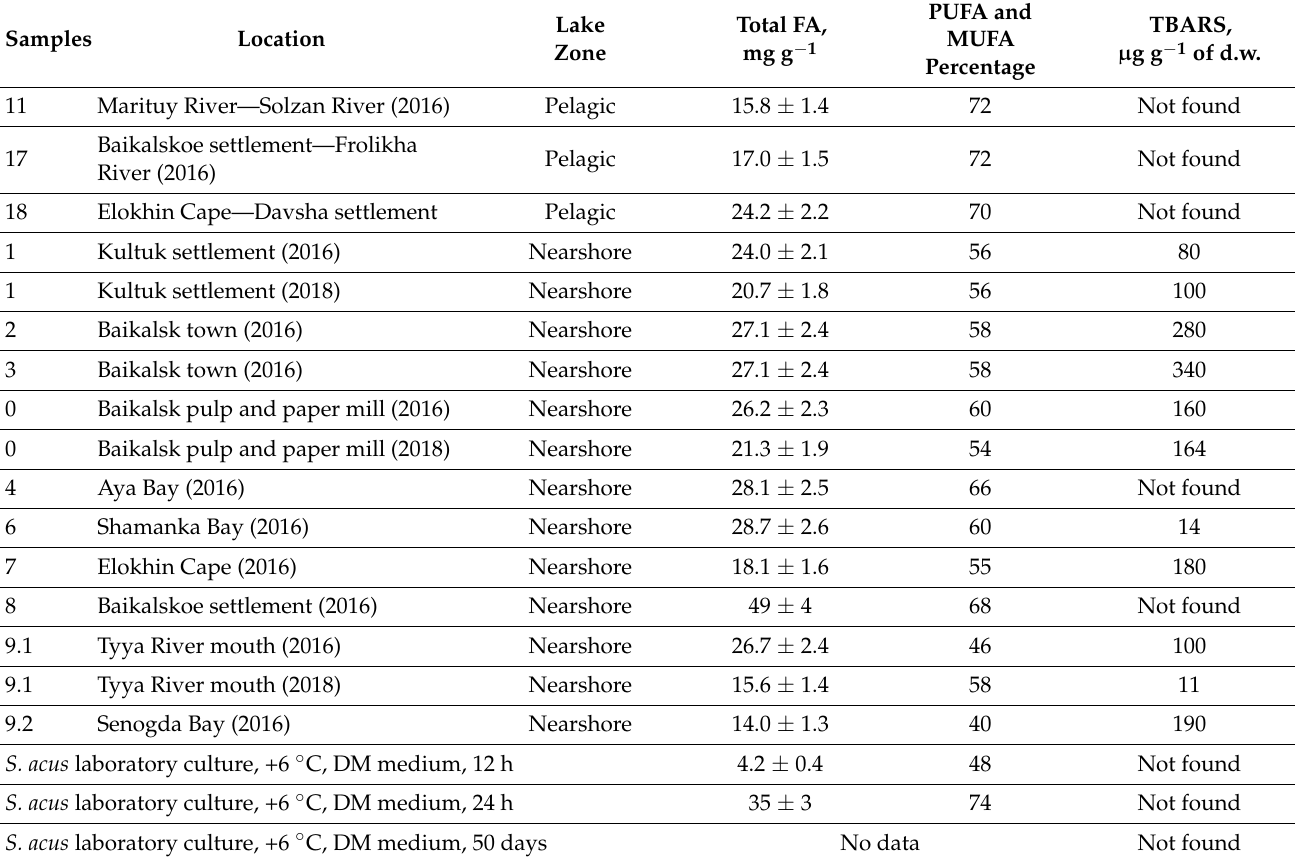
Table 5. TBARS concentrations ( µ g g − 1 of d.w.) in some phytoplankton samples collected in